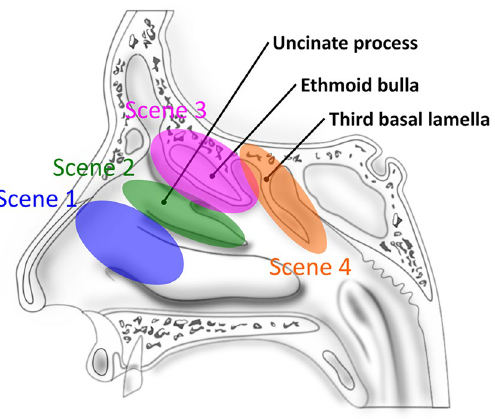
Figure 6. Sagittal view through the ethmoidal sinuses. In endoscopic sinus surgery, the treatment gradually moves to the back of the nose as the operation progresses.